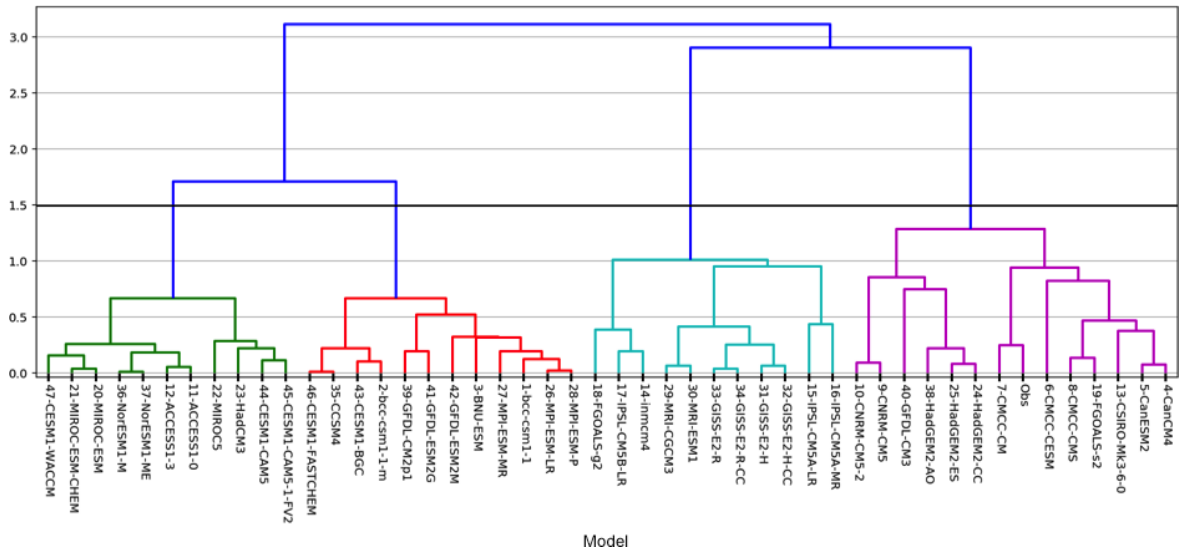
Figure 5. HAC dendrogram. The horizontal line displays the 47 CMIP5 models, each model being associated with its seven-component skill vector. As the dendrogram represents a hierarchy of clusters, the numbers on the y axis give the distance between two clusters. We note an optimal “jump” on this graph: the level 1.5 on the vertical axis (materialized by a horizontal black line) is associated with four well-separated clusters corresponding to four model groups that are very different.